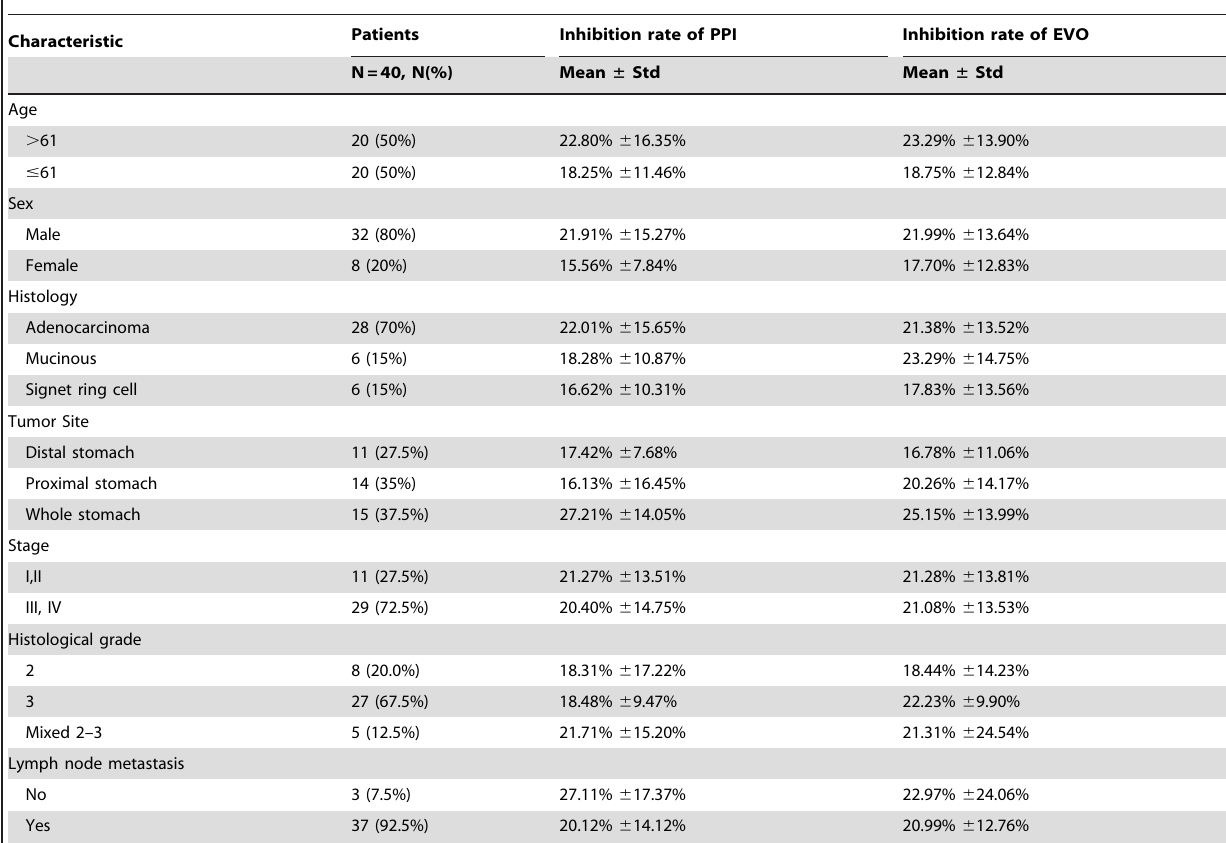
Table 1. Patient